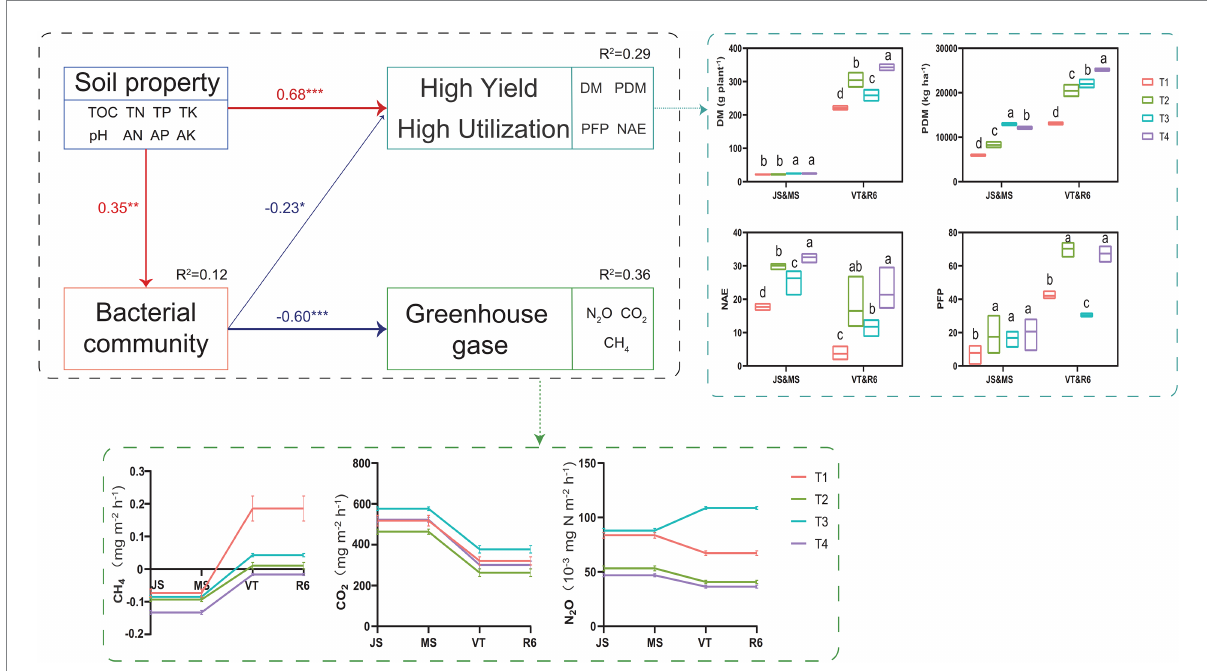
FIGURE 7 The value above the structural equation model (SEM) line represents the path coefficient. The red line represents the positive path coefficient, and the blue line represents the negative path coefficient ( *** p < 0.001; ** p < 0.01; * p < 0.05). JS, jointing stage of wheat; MS, maturity stage of wheat; VT, tasseling stage of maize; R6, maturity stage of wheat; DM, dry matter of crop; PDM, population dry matter of crop; PFP, N partial factor productivity; NAE, N agronomic